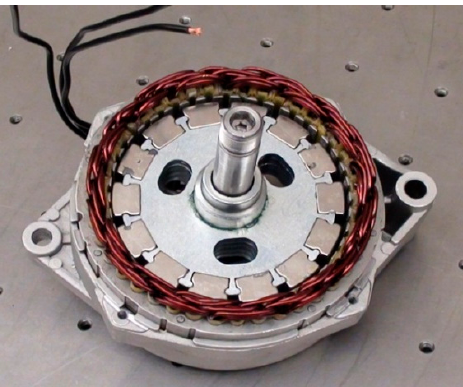
Figure 3. Demonstration machine: a three-phase permanent magnet generator.